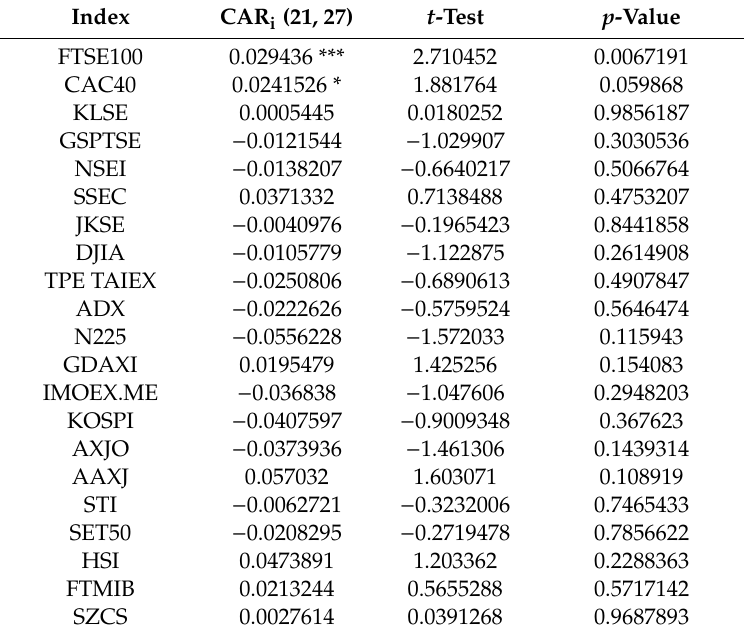
Table 8. Cumulative abnormal return in the event window (21, 27).